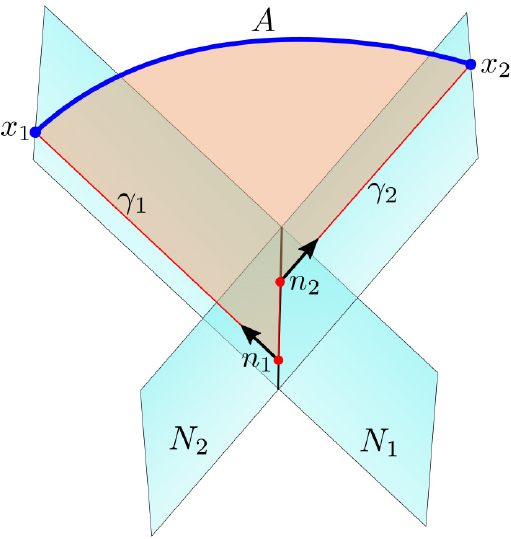
Figure 9: EWCS for the single interval in the flat-space